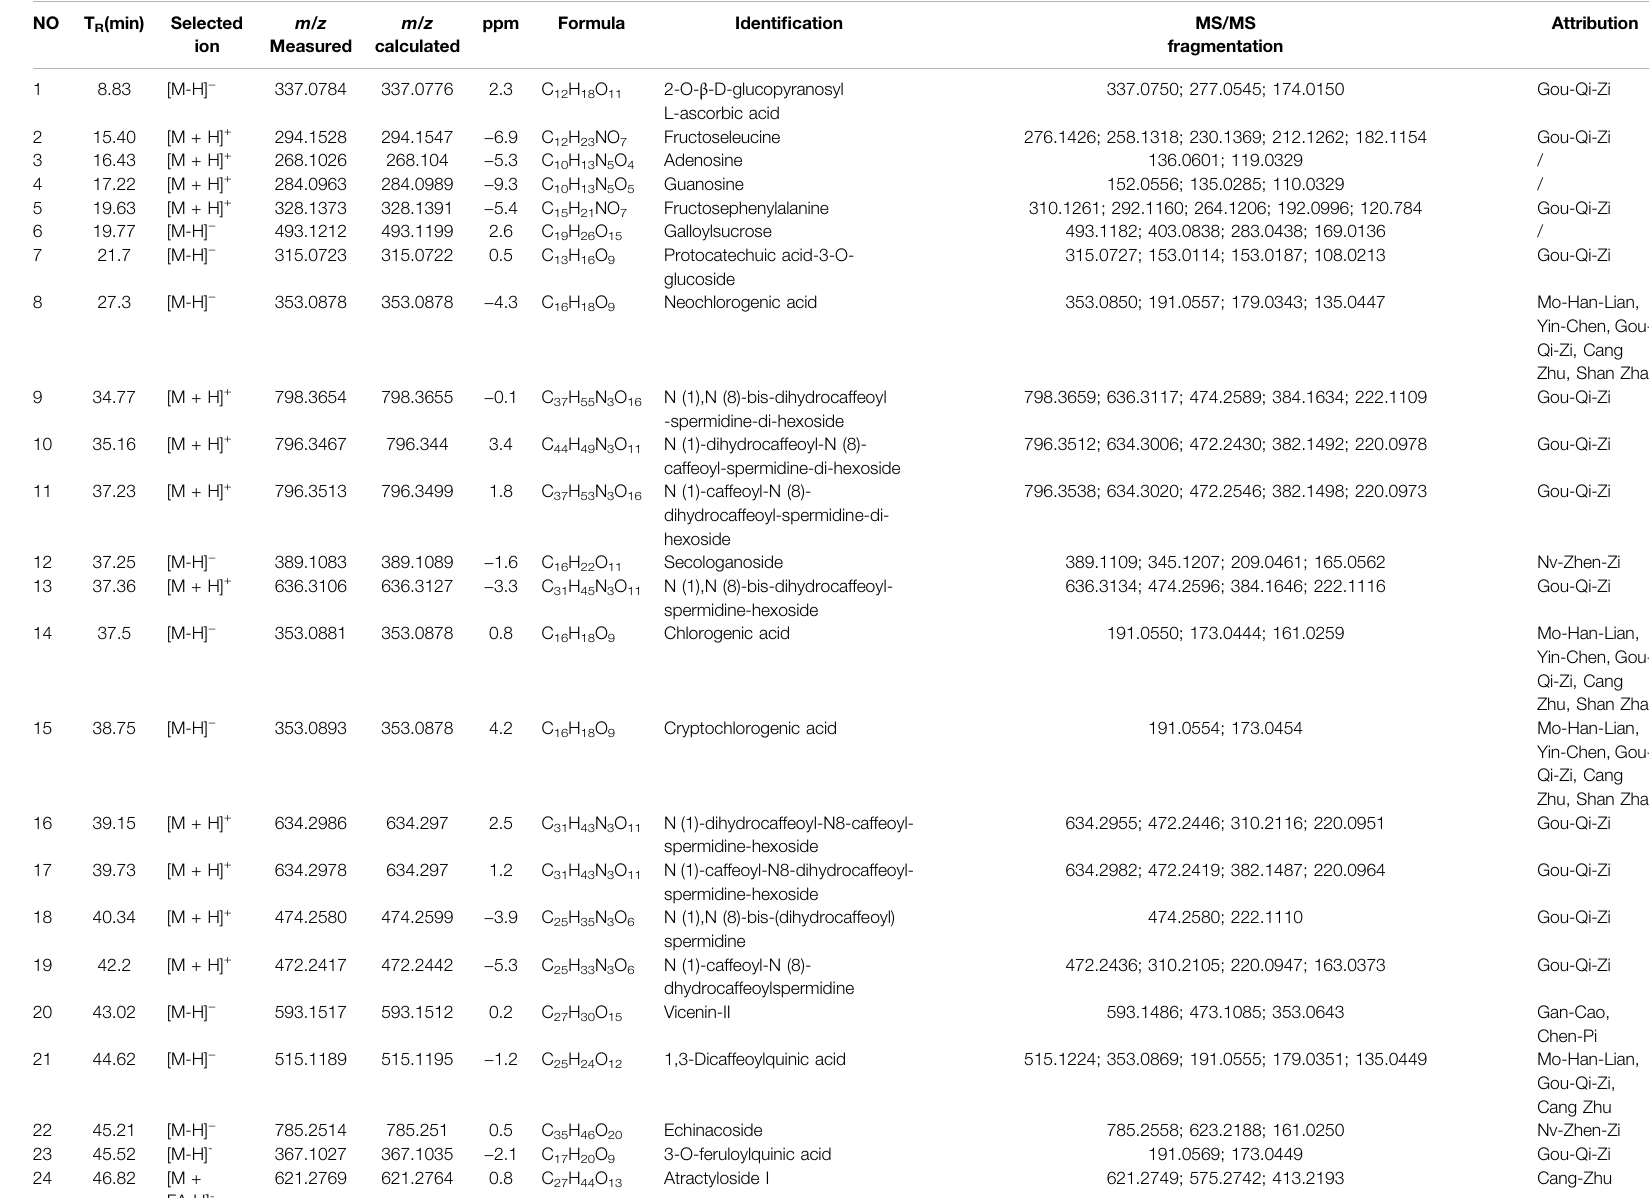
TABLE 2 | The detected ion chromatogram of constituents in